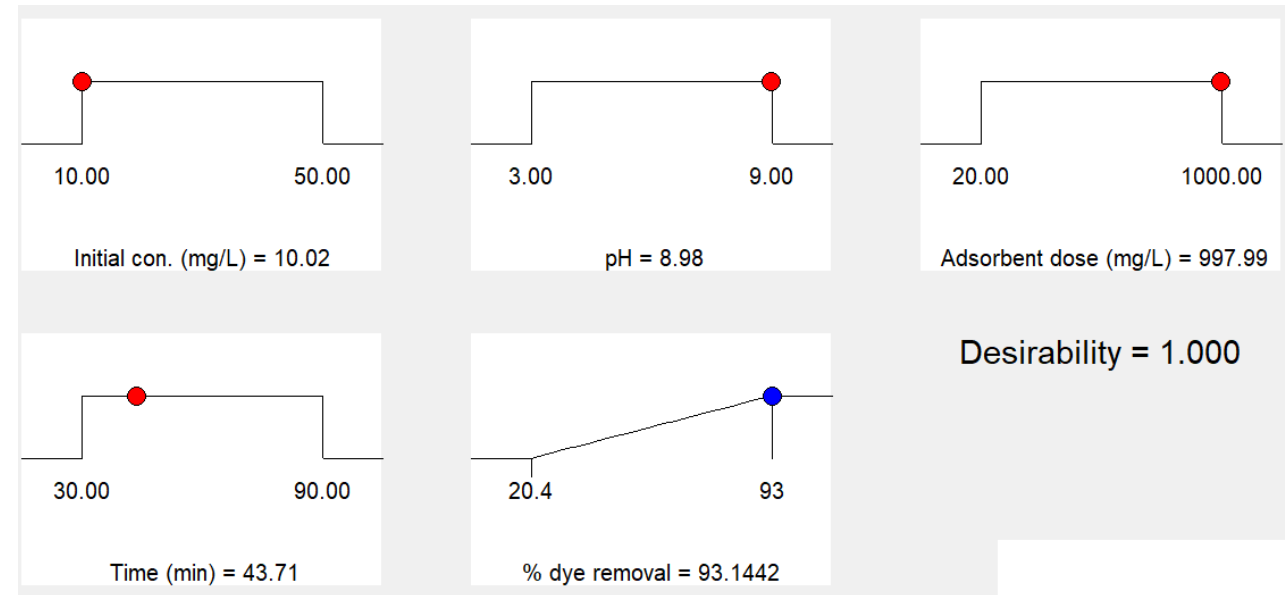
Figure 16. Ramp plot for the numerical optimized parameters.